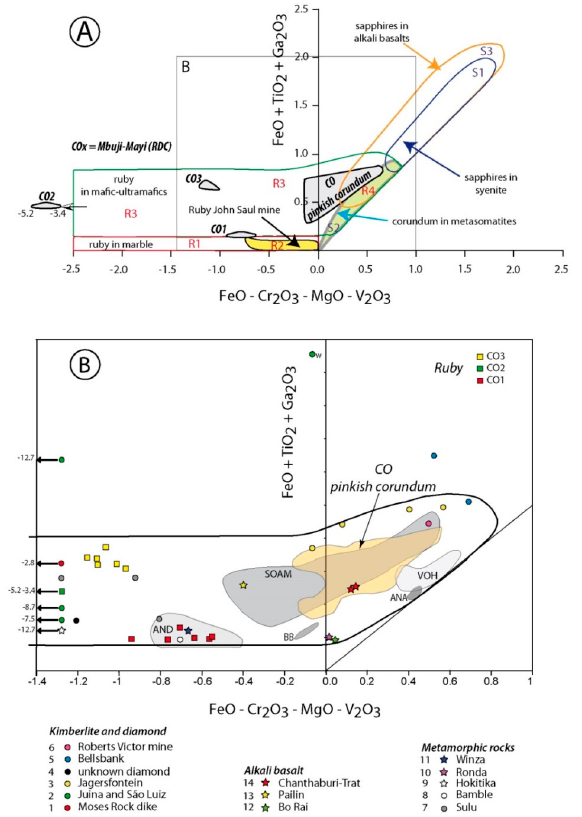
Figure 28. Chemical variation of ruby and pinkish corundum from the Mbuji-Mayi kimberlite in the Democratic Republic of Congo. ( A ) The FeO-Cr 2 O 3 -MgO-V 2 O 3 versus FeO + TiO 2 + Ga 2 O 3 (analysis in wt %) classification diagram, modified from [84]. The different chemical fields of the studied corundum are reported with respectively those for ruby (samples CO1, CO2, and CO3) and pinkish corundum (CO, yellowish field); ( B) Field of chemical compositions of the ruby and pink sapphires from Mbuji-Mayi. Different chemical fields are reported for ruby from Beni Bousera in Morocco (BB), Soamiakatra (SOAM), Anavoha (ANA), Vohitany (VOH), and Andriba (AND) from Madagascar. Other representative compositions of ruby from occurrences in kimberlite and diamond, alkali basalt, and metamorphic rocks are also shown; modified from [84,164].